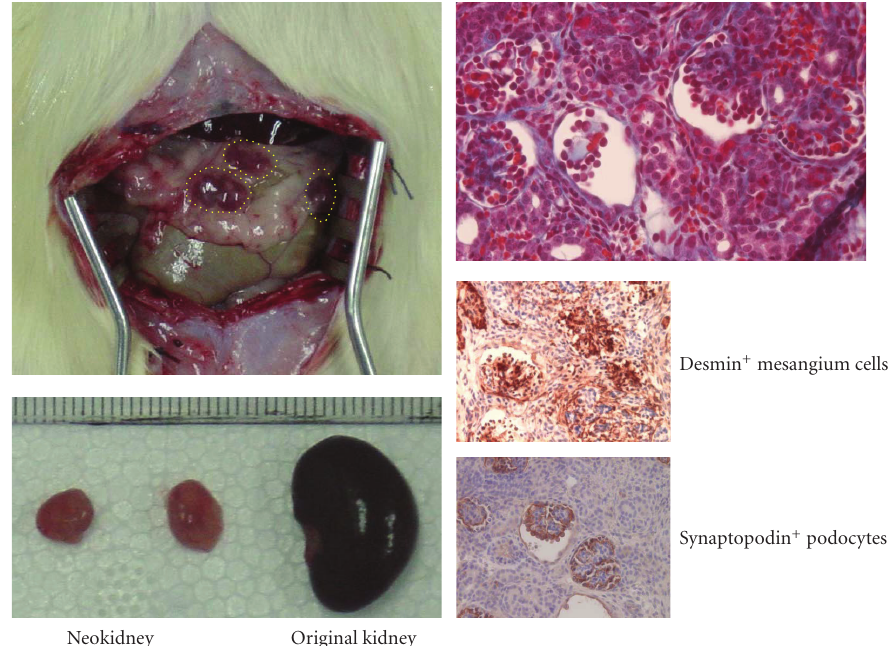
Figure 2: Development of neokidney derived from hMSCs. Kidney anlagen derived from MSCs was transplanted into rat omentum. After this relay culturing, hMSCs formed into neokidney in the rat omentum. Histological analysis revealed a well-di ff erentiated kidney structure (right panels). Desmin-positive mesangial cells and synaptopodin-positive podocytes can be seen (right